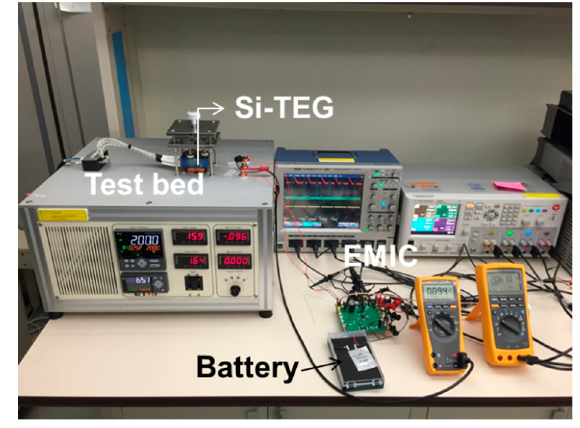
Figure 17. The Li-ion battery charging setup.